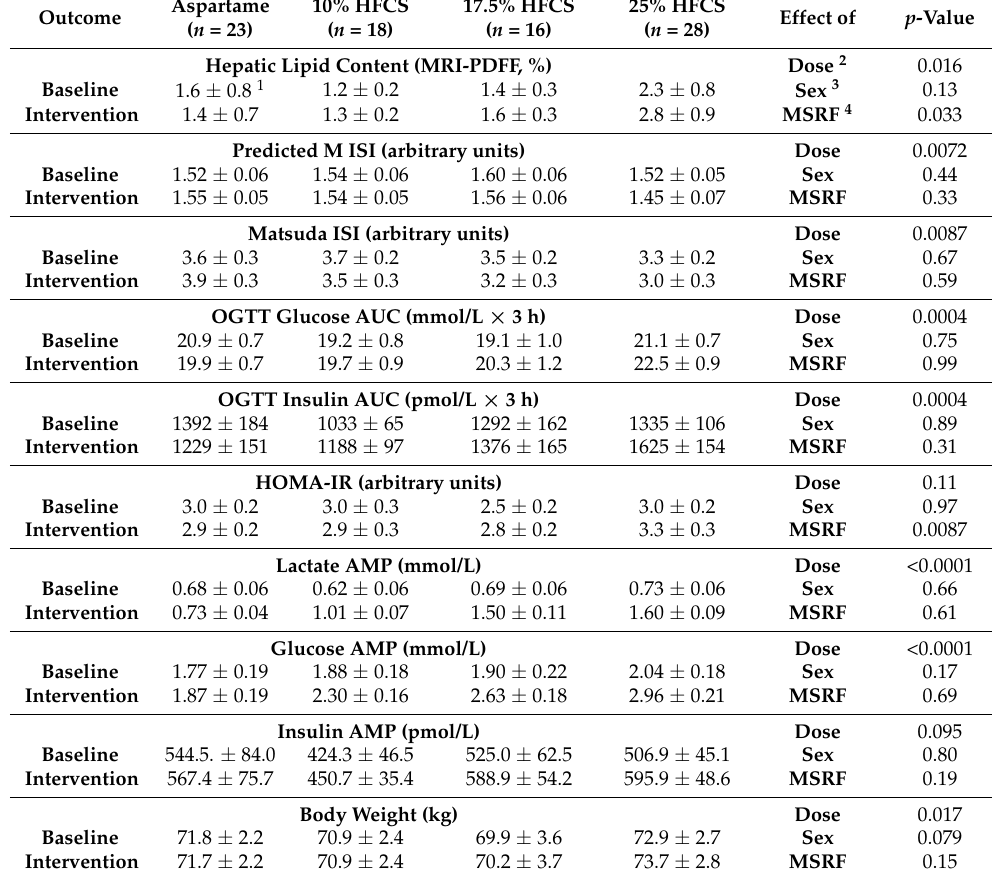
Table 2. Outcomes at baseline and intervention.